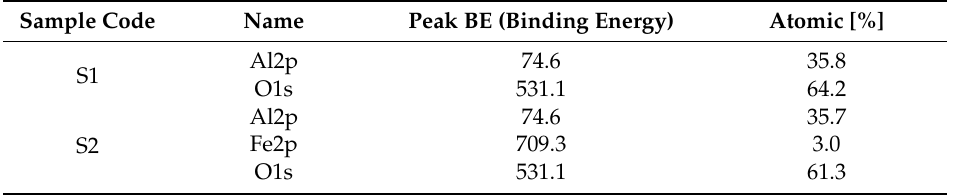
Figure 1. XPS survey spectra of: ( a ) XPS spectra for S1 sample compared with 316L sample autoclaved before PEO; ( b ) XPS survey spectra of 316 L samples after PEO treatment: S1 (red line) and S2 (blue line). Table 2. XPS elemental composition of samples (S1 and